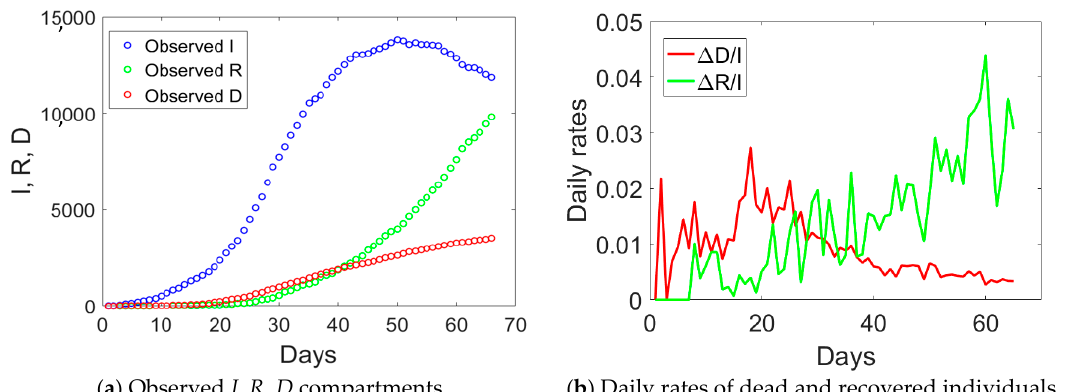
Figure 2. Observed compartments ( a ) and daily rates of dead and recovered individuals ( b ) in Emilia